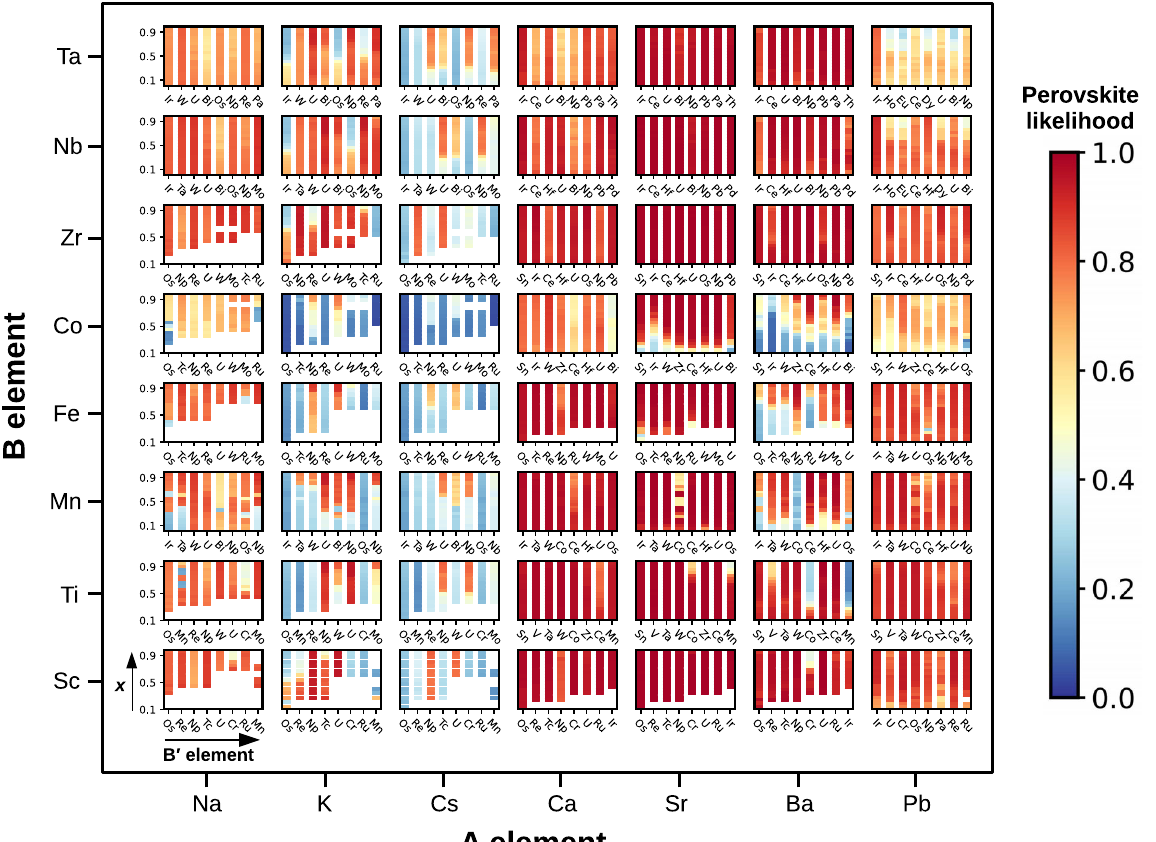
Fig. 3 Perovskite likelihood of selected A ð B 1 (cid:2) x B 0 x Þ O 3 systems as predicted by the GBC model. Each panel depicts the classi fi cation probability variation as the content x of different B 0 cations increases, for some commonly observed A and B element combinations. Empty opposed to four stable ternary perovskites, KNbO 3 , KTaO 3 , KUO 3 and KIO 3 . Despite having no training data with A-site K and B-site U occupied perovskites, the model predicts that U can be alloyed with Nb, Ta or even Ti and Zr to forge a perovskite. This claim is somewhat supported